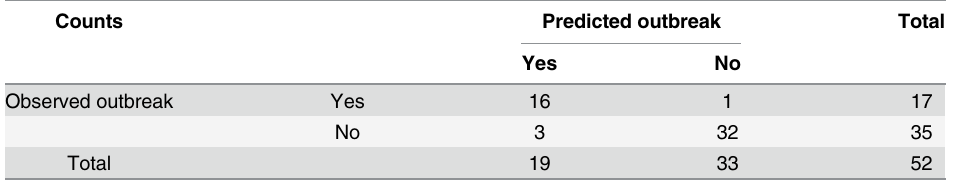
Table 2. Summary of out-of-sample prediction for dengue epidemics in Zhongshan (2013/12/28 – 2014/